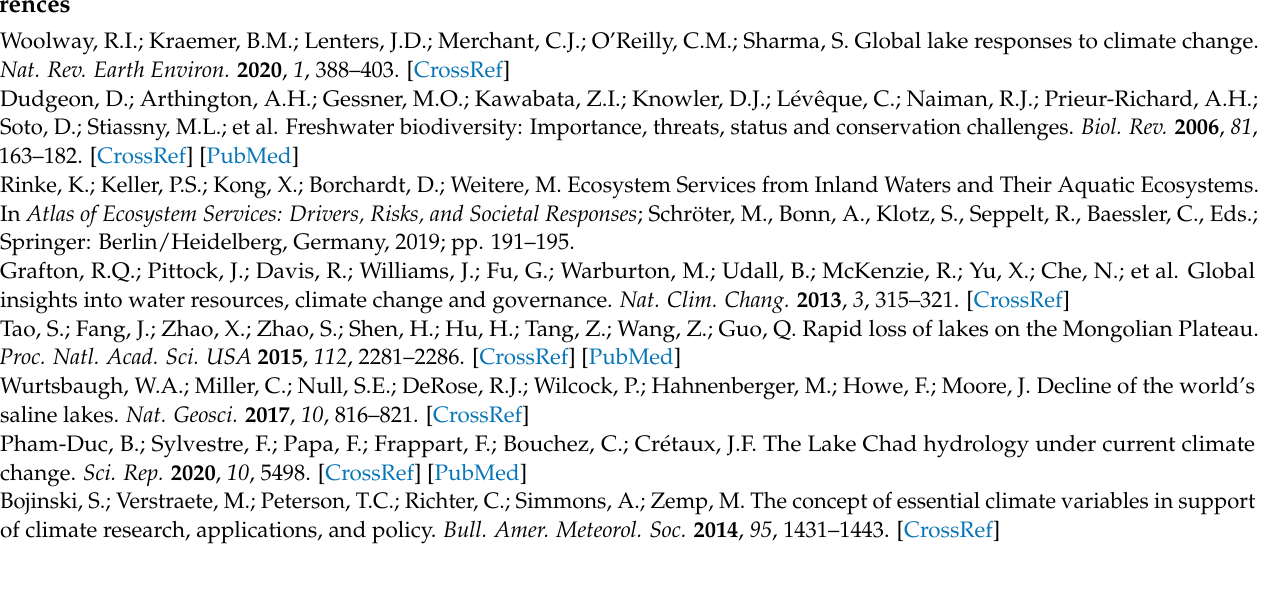
maps. Figure S2. Sampling-based method for calculating the regression slope between lake area and lake water levels. Figure S3. Spatial pattern and size distribution of the lakes with ICESat, ICESat-2, or both observations. Figure S4. Comparison of in situ and area-derived water levels calculated by different parameters. Figure S5. Spatial distribution of the lakes used for validating the results of the current study. Figure S6. Validation of lake water levels. Figure S7. Accuracy assessment for the estimated lake volumes. Figure S8. Shoreline changes for two lakes with drastic volume changes. Figure S9. P values of the correlation coefficients between monthly lake volume and TWS. Figure S10. Area-derived water levels compared with in situ lake water levels for Lake Hongze in the lower Yangtze River Basin in China. Figure S11. Validation of area-derived water levels for the 132 lakes. Figure S12. Relationship between the accuracy of the estimated lake water levels (NRMSE, %) and the number of paired observations between lake water level and lake area. Figure S13. Time series of the estimated lake volumes compared to in situ lake volumes for three typical lakes. Table S1. Validation of ICESat/ICESat-2-derived lake water levels. Table S2. Validation of area-derived water levels. Table S3. Validation of the estimated lake